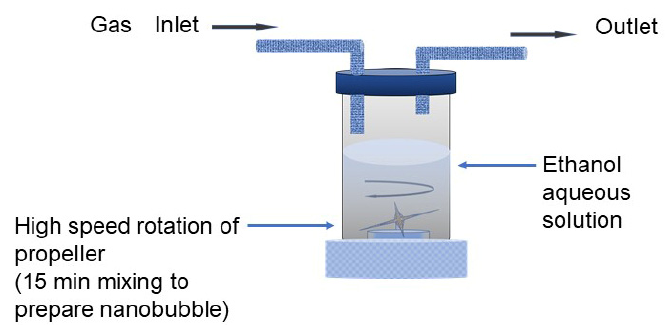
Figure 1. Preparation method of nanobubbles.